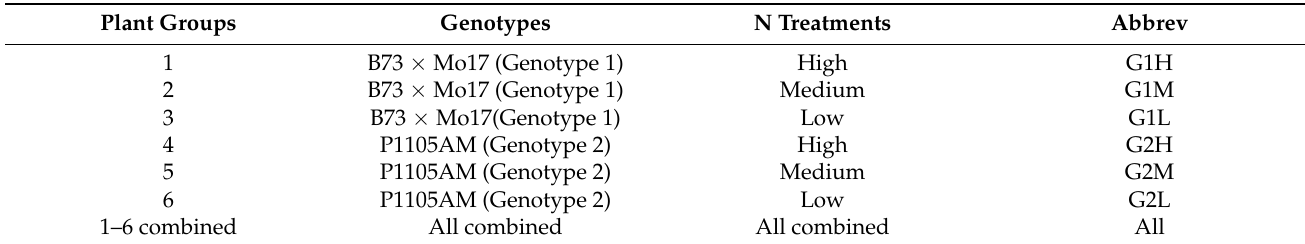
Table 1. Abbreviations of plant plots with different nitrogen treatments and